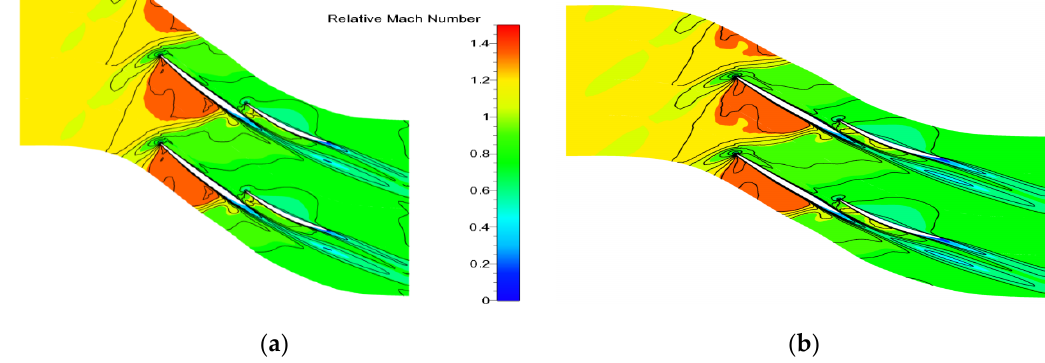
Figure 11. The relative Mach number of 10% span of the original and optimized tandem rotor. ( a ) Original tandem rotor (ORG); ( b ) optimal tandem rotor (OPT).